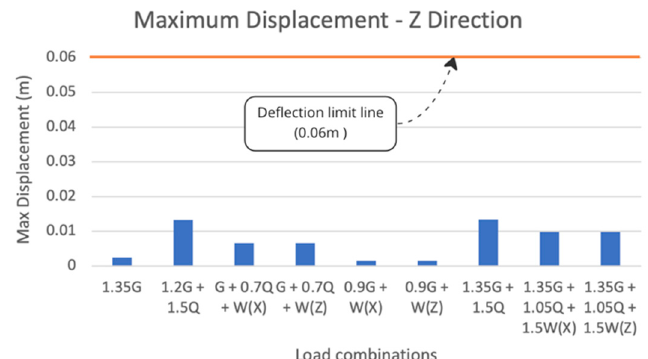
Figure 23. Deflection limit and the maximum vertical deflection for each load combination for PERIH.